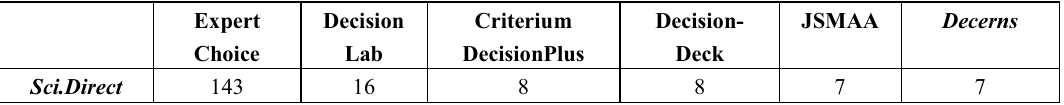
Table 2. Number of articles in ScienceDirect database for 2009-2014 in which indicated software AND words associated with risk management were mentioned in full text of an